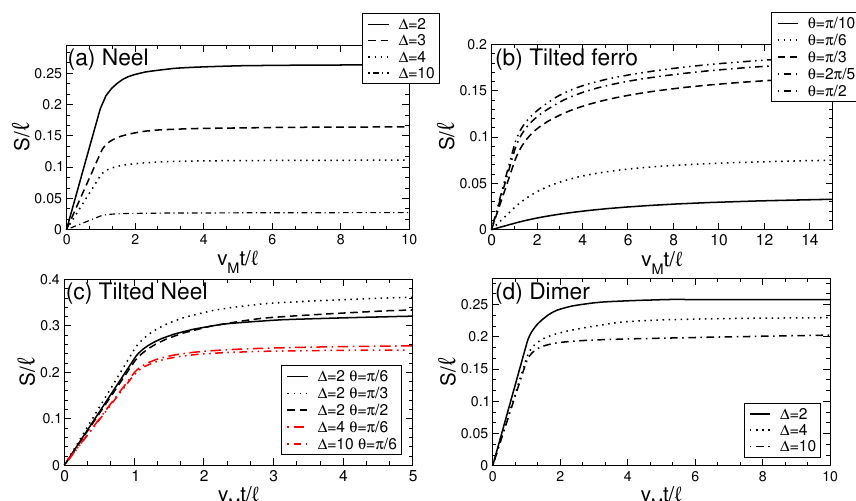
Figure 2: Quasiparticle prediction for the entanglement evolution after a global quench in the XXZ spin chain. In all panels the entanglement entropy density S /(cid:96) is t /(cid:96) , with (cid:96) the size of A and v plotted against the rescaled time v the maximum M M velocity. Different panels correspond to different initial states, namely the Néel state (a), tilted ferromagnet with Delta = 2 (b), tilted Néel (c), and dimer state (d). Dif- ferent curves correspond to different values of the chain anisotropy ∆ > 1 and tilting angles ϑ of the initial state. Figure taken from Ref. [ 94